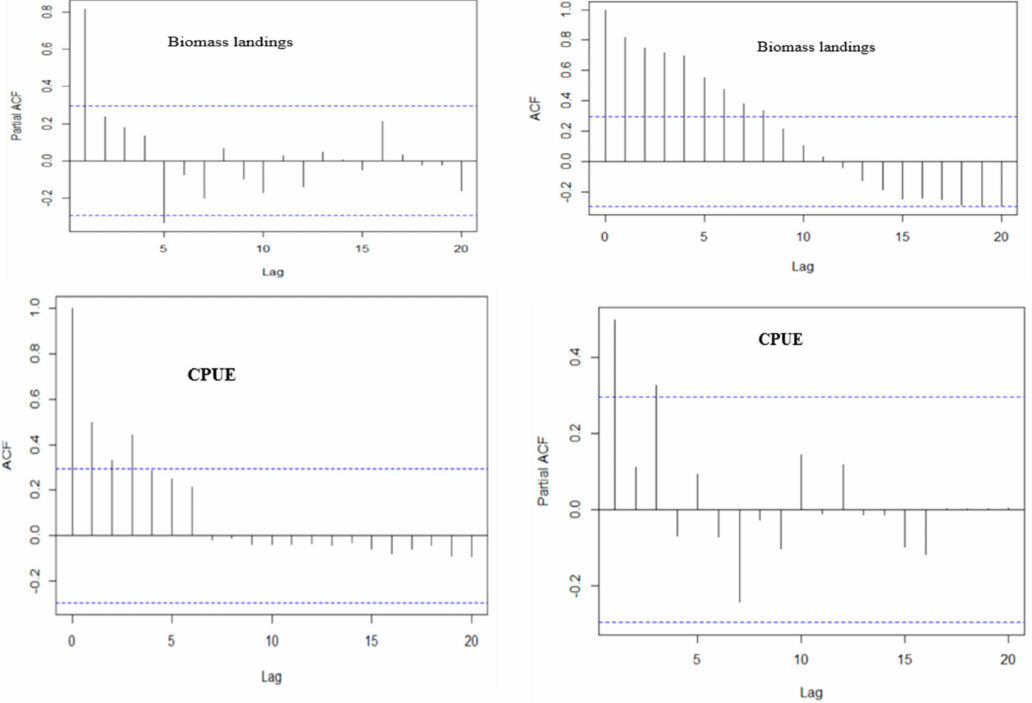
Figure 3. Autocorrelation and partial autocorrelation functions of original fishery landings and